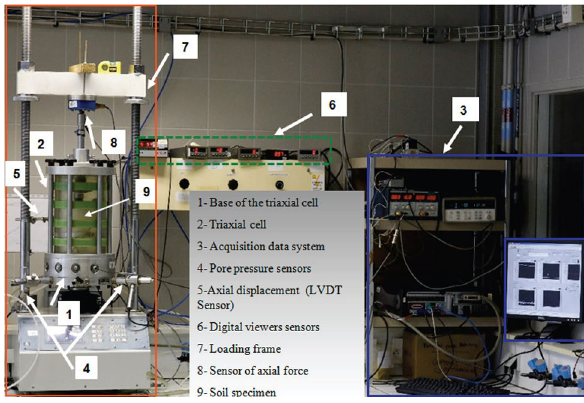
Fig. 3 Grain size distribution curve of Chlef sand